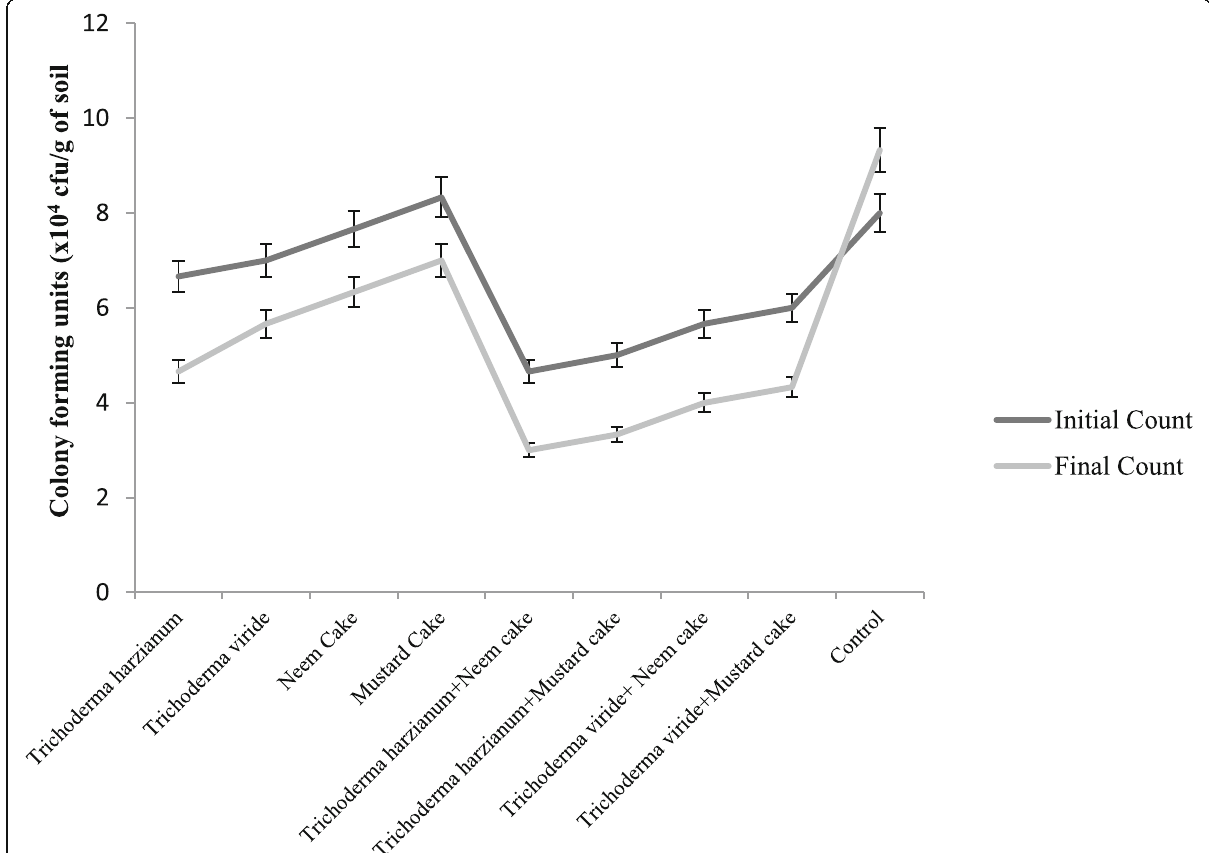
Fig. 3 Effect of the application of the tested bioagents and organic amendments on the inoculum density per gram of Rhizoctonia bataticola (cfu × 104/g of